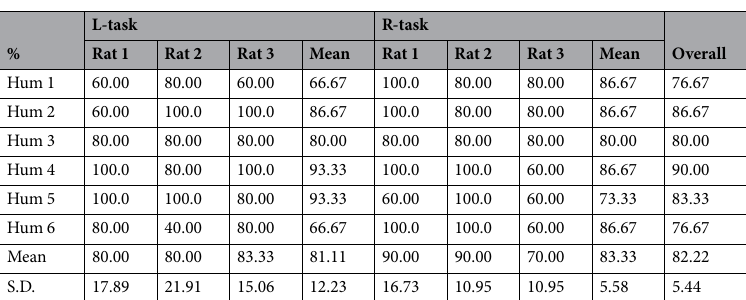
Table 1. Mean BBI success rates (%) for the T-maze task.